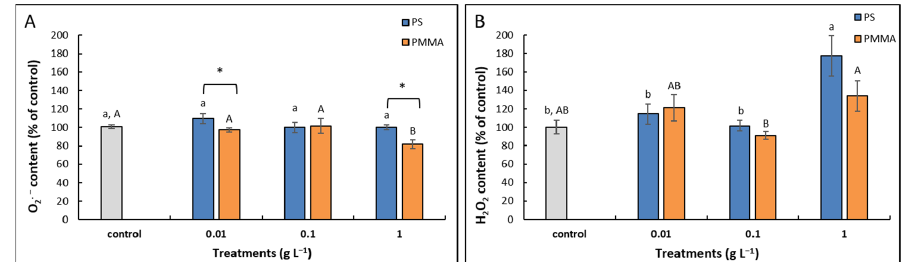
Figure 5. Content of O 2• − ( A ) and H 2 O 2 ( B ) in A. cepa control roots and after 72 h treatment with 0.01, 0.1, and 1 g L − 1 of PS-MPs and PMMA-MPs. Values are means ± standard errors of two different experiments, each with 6 replicas ( n = 12). If columns are marked with different letters or asterisk, the treatments are significantly different at p ≤ 0.05 (one-way ANOVA followed by Duncan post hoc test); small letters mark the differences among different concentrations of PS-MPs and control, capital letters mark the differences among different concentrations of PMMA-MPs and control, and asterisk (*) denotes difference between the same concentration of different MP types.